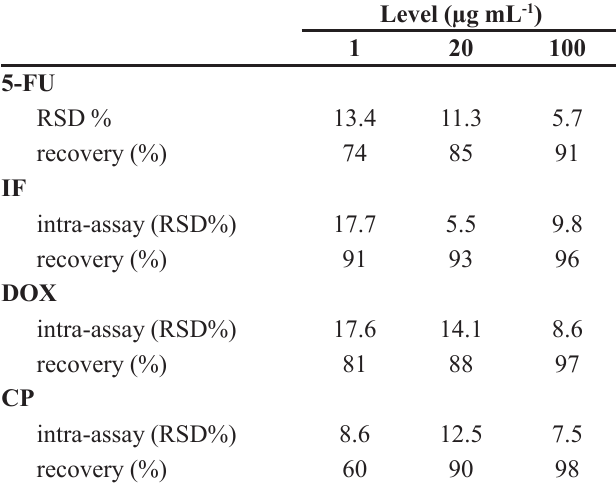
TABLE IV - Precision and recovery of the method for simultaneous analysis of fluorouracil (5-FU), ifosfamide (IF), doxorubicin (DOX) and cyclophosphamide (CP) by LLE- HPLC-UV in